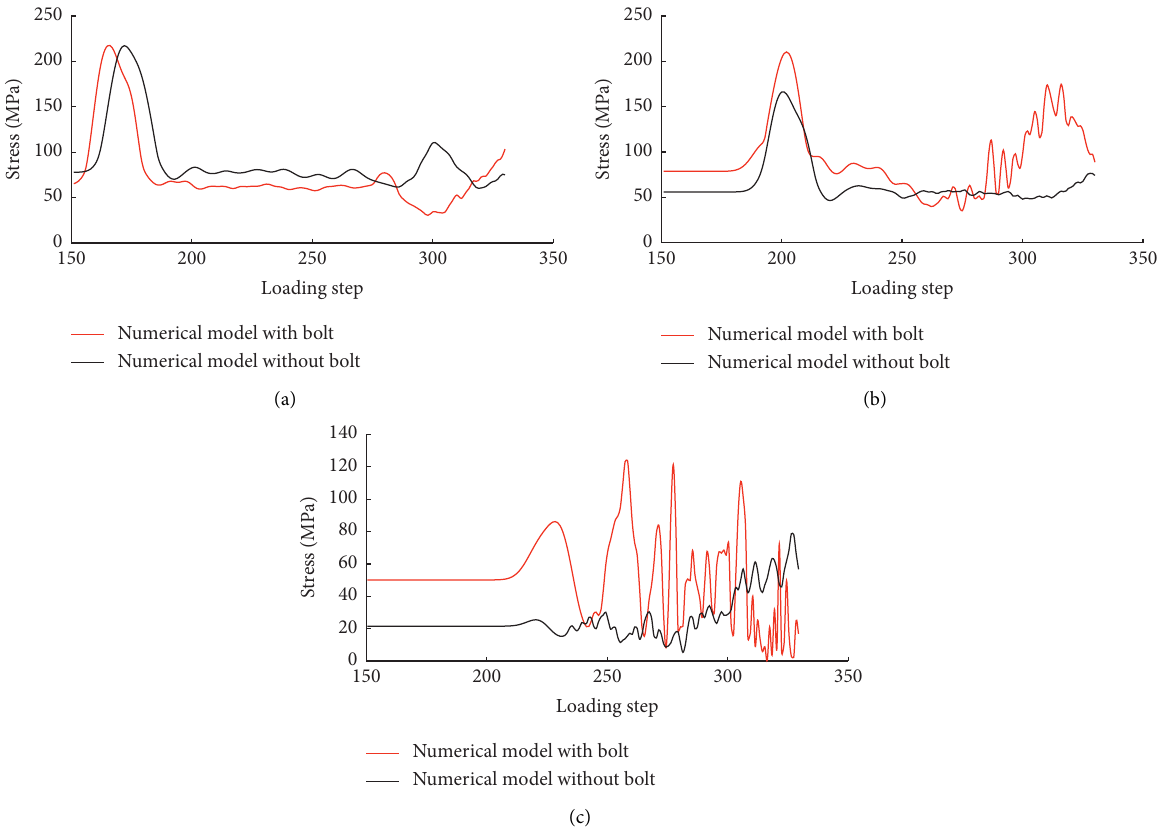
Figure 9: Stress comparison of the two numerical models at the same point. (a) Point A1. (b) Point A2 (c) Point A3.